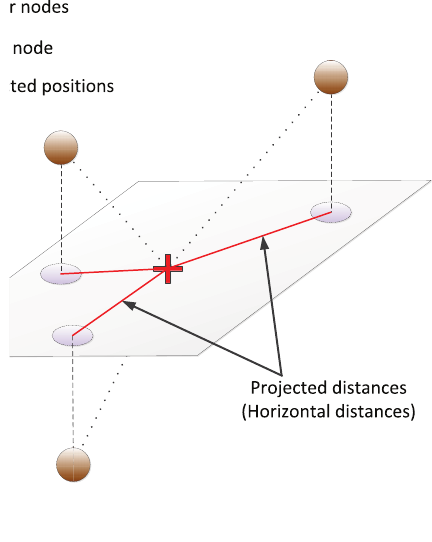
Figure 1. Projection of pair-wise distances on the horizontal plane crossing the